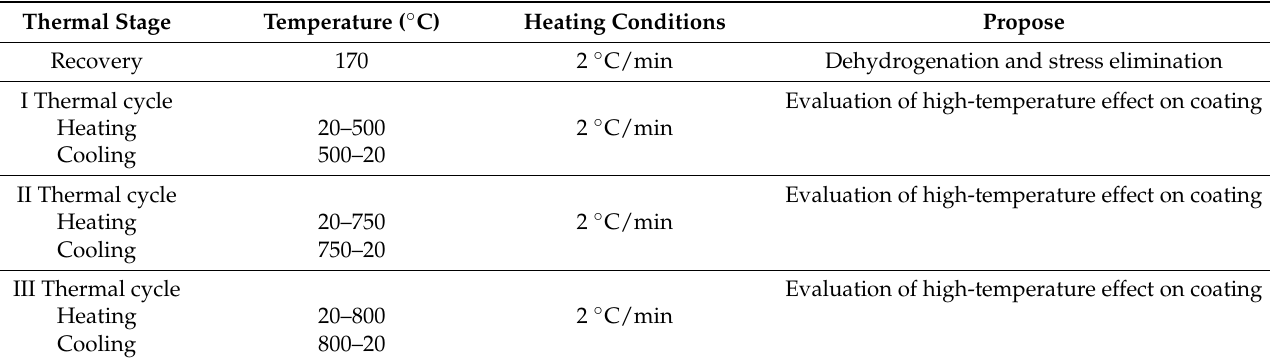
Table 2. Operative parameters for the thermal recovery and cycling